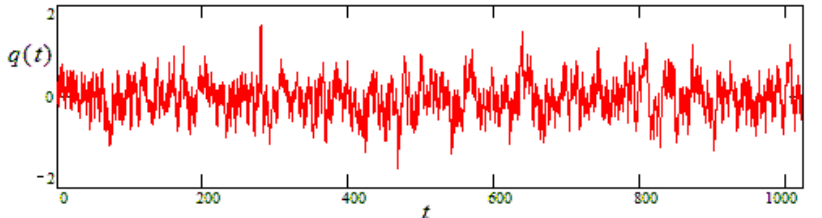
Figure 4: Temporal evolution of the order parameter q ( t ) for the noisy mean-field model in the monomer case.